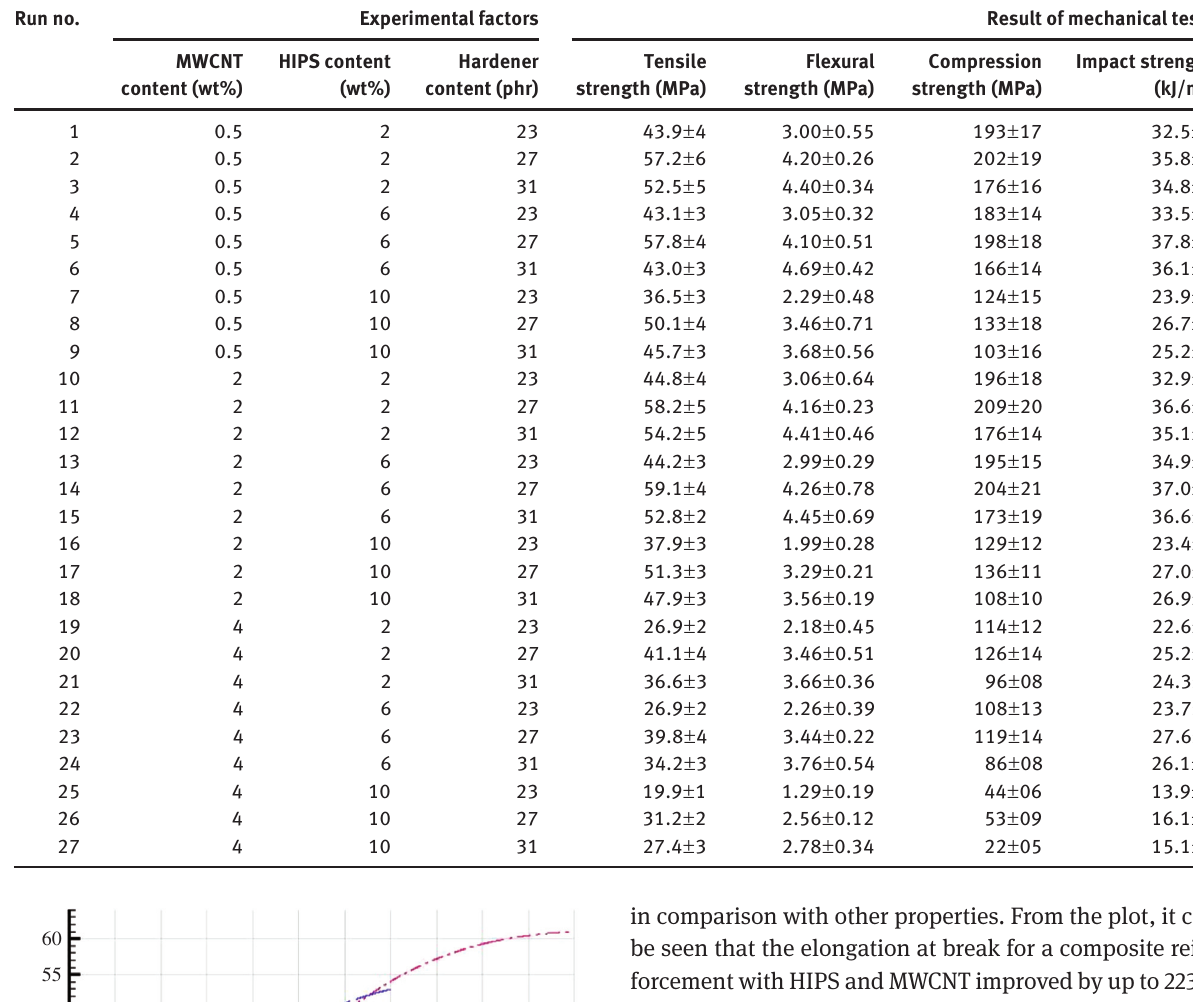
Table 1 Values of ultimate tensile strength, ultimate bending strength, ultimate compression strength and impact strength. Run no.